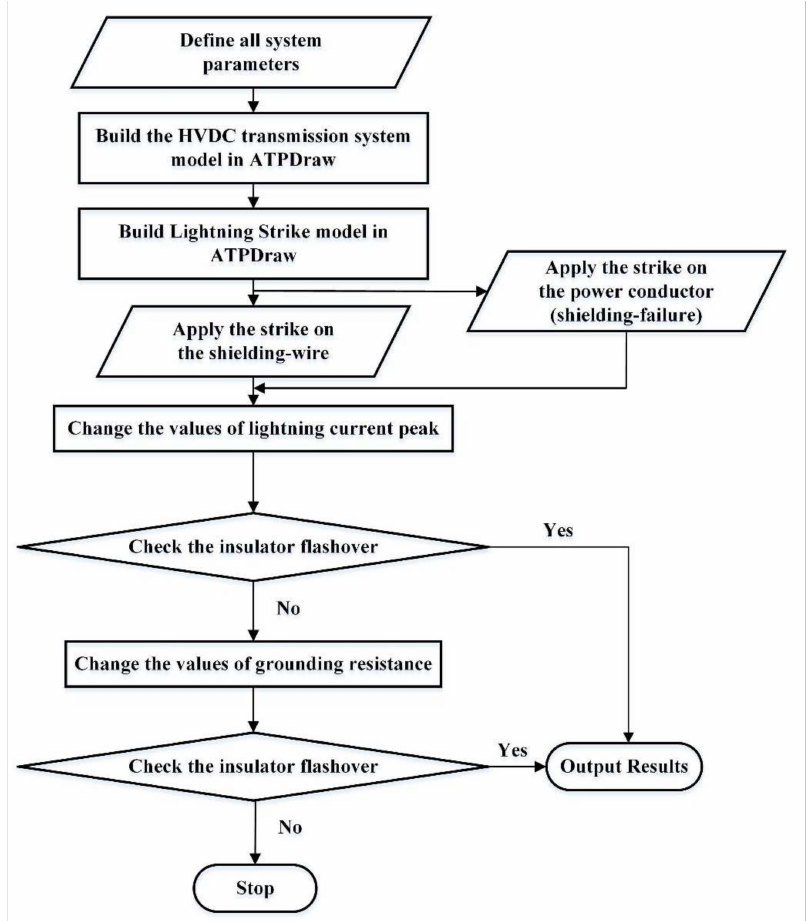
Figure 9. Flowchart describing this work’s